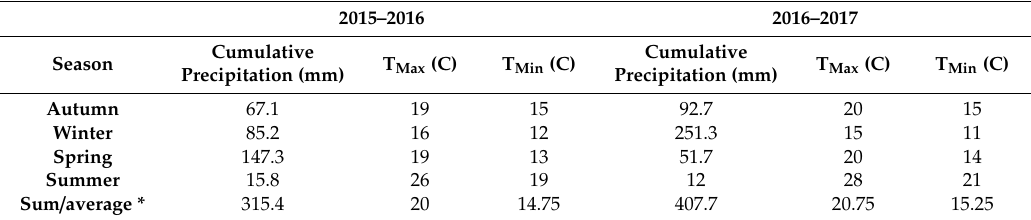
Table 6. Seasonal precipitation and temperature of the two years of field experiment in Fritissa / Mateur, Bizerte region.